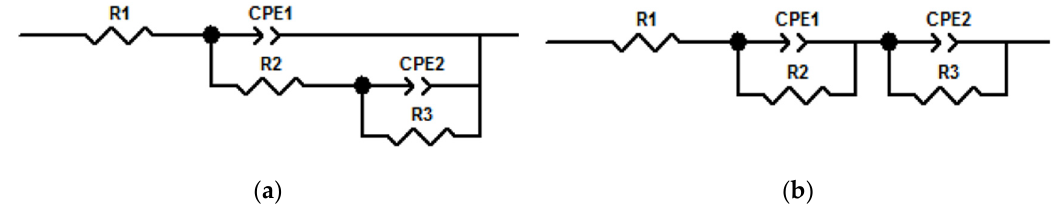
Figure 2. Equivalent circuit diagram: ( a ) no prefabricated crack specimens, such as reactive powder concrete (RPC) and basalt fiber reactive powder concrete (BFRPC); ( b ) Prefabricated crack specimens, such as RPC-Crack (C), RPC-C- steel-concrete interface damage (SCID), BFRPC-C, and BFRPC-C- SCID.